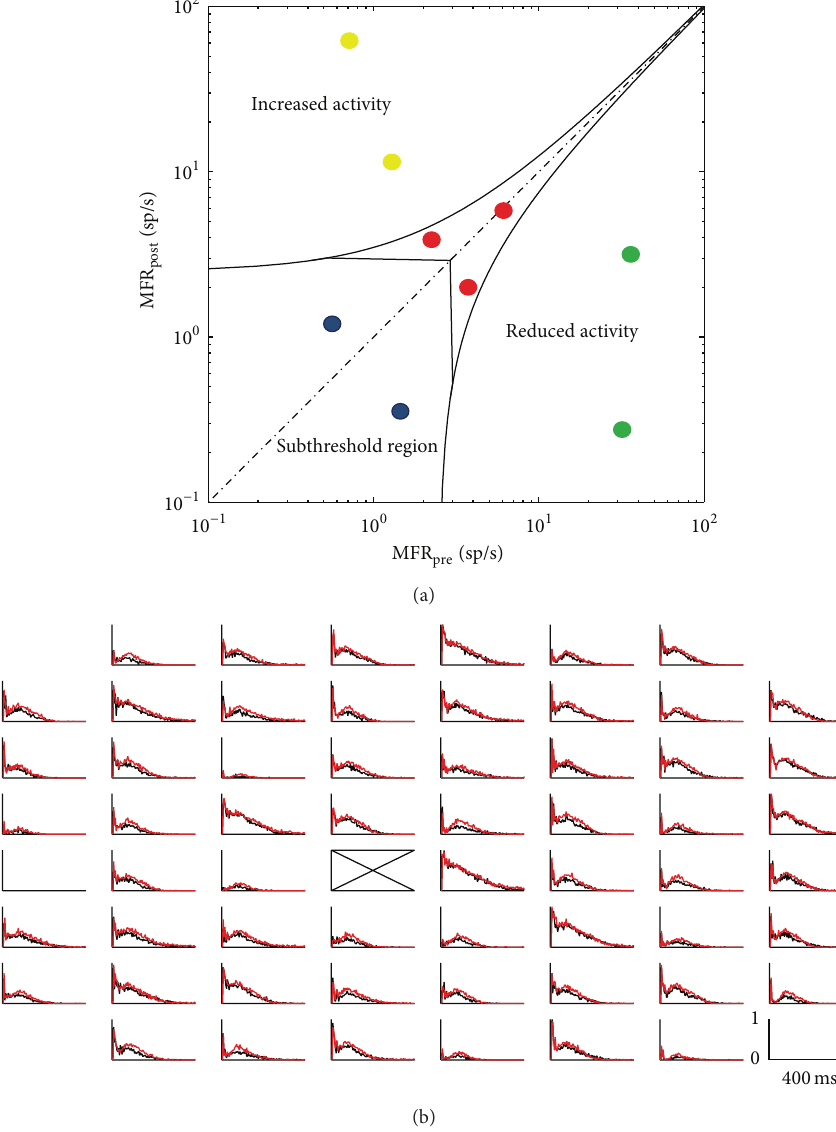
Figure 3: Initial conditions necessary to induce plasticity in cortical cultures. (a) Bilogarithmic plot of the mean spontaneous firing rates of cortical neurons. Spontaneous activity of each network was measured at the beginning of the experiment (MFR pre ) and after the first test stimulus session (MFR post ). Curved lines denote confidence intervals (see [20]). The used colors have the following meanings: red circles represent cultures that verify the MFR stability conditions and are potentially able to show plastic behavior. Blue circles indicate culture with a firing rate too low, while yellow and green circles represent unstable cultures which increase (yellow) or decrease (green) their firing rate. (b) PSTH map. This example shows the effects on the network during the stimulation from the site indicated by the cross. The two superimposed profiles of the PSTH represent the responses of the network to two different sessions of stimulation. Bin size = 4ms; 𝑥 -axis [0,400] ms; 𝑦 -axis scale [0,1] is the probability to evoke